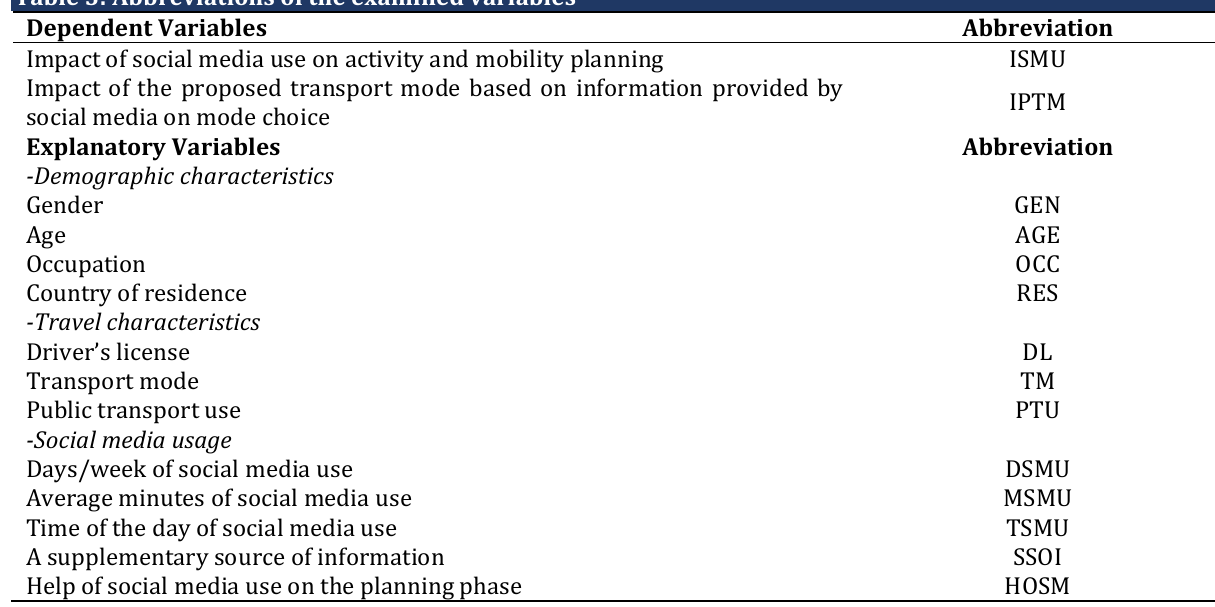
Table 3: Abbreviations of the examined variables Dependent